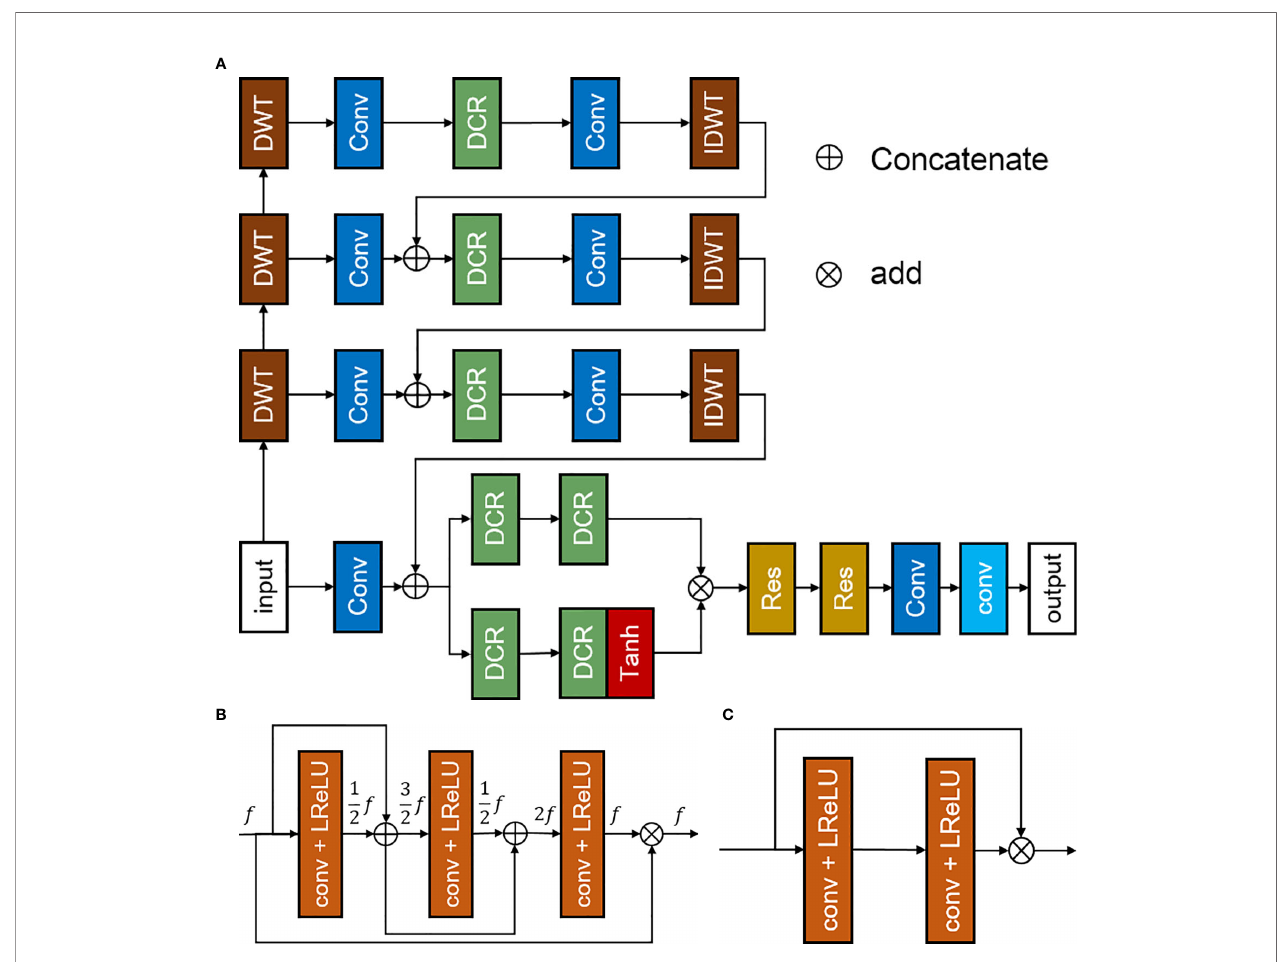
FIGURE 1 | Discrete-wavelet-transform neural network (DWTN), including (A) the structure of the DWTN network, (B) the structure of the densely connected residual (DCR) block, and (C) the structure of the residual